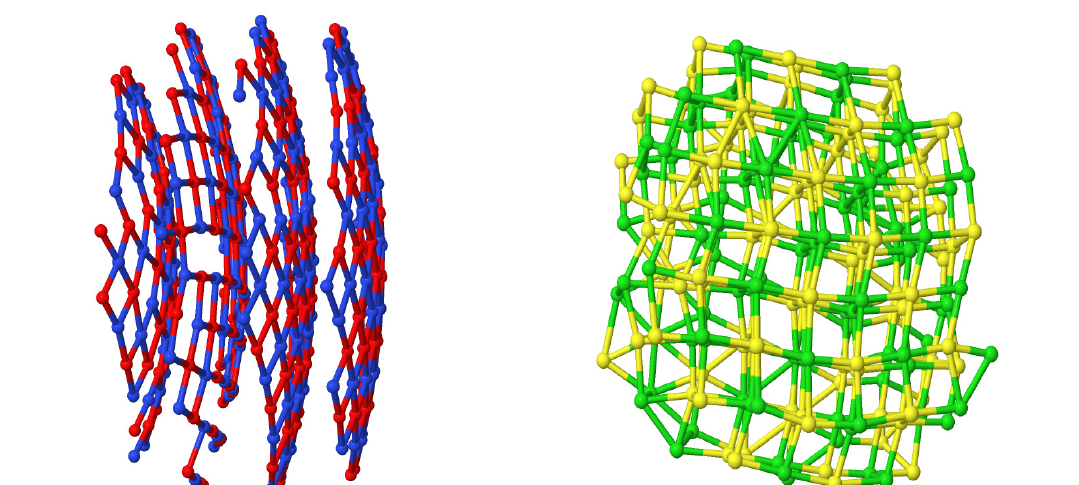
Figure 5: Anti-ferromagnetic spherical lattices found for 0 < α < β . Left: A sample with two-dimensional square lattice layers from a simulation with 15000 instantons at α = 2 / 3 and β = 1. Right: A sample with two-dimensional rhombic layers from a simulation with 15000 instantons at α = 0.1 and β =